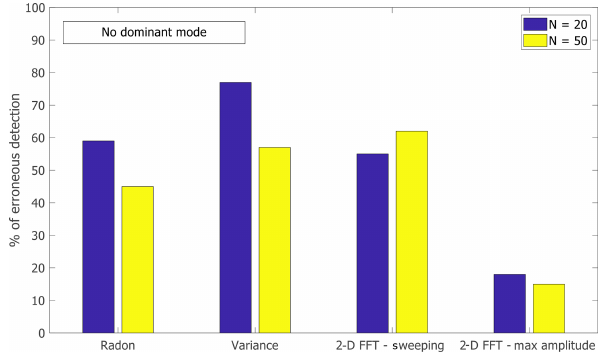
Figure 4. The percentage of erroneous detection of each variant of the methods when there is no dominant input